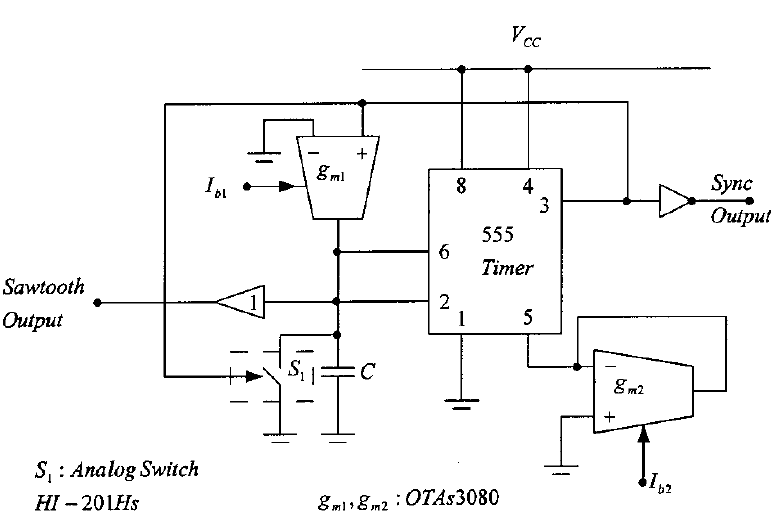
FIGURE 1 Proposed current-controlled